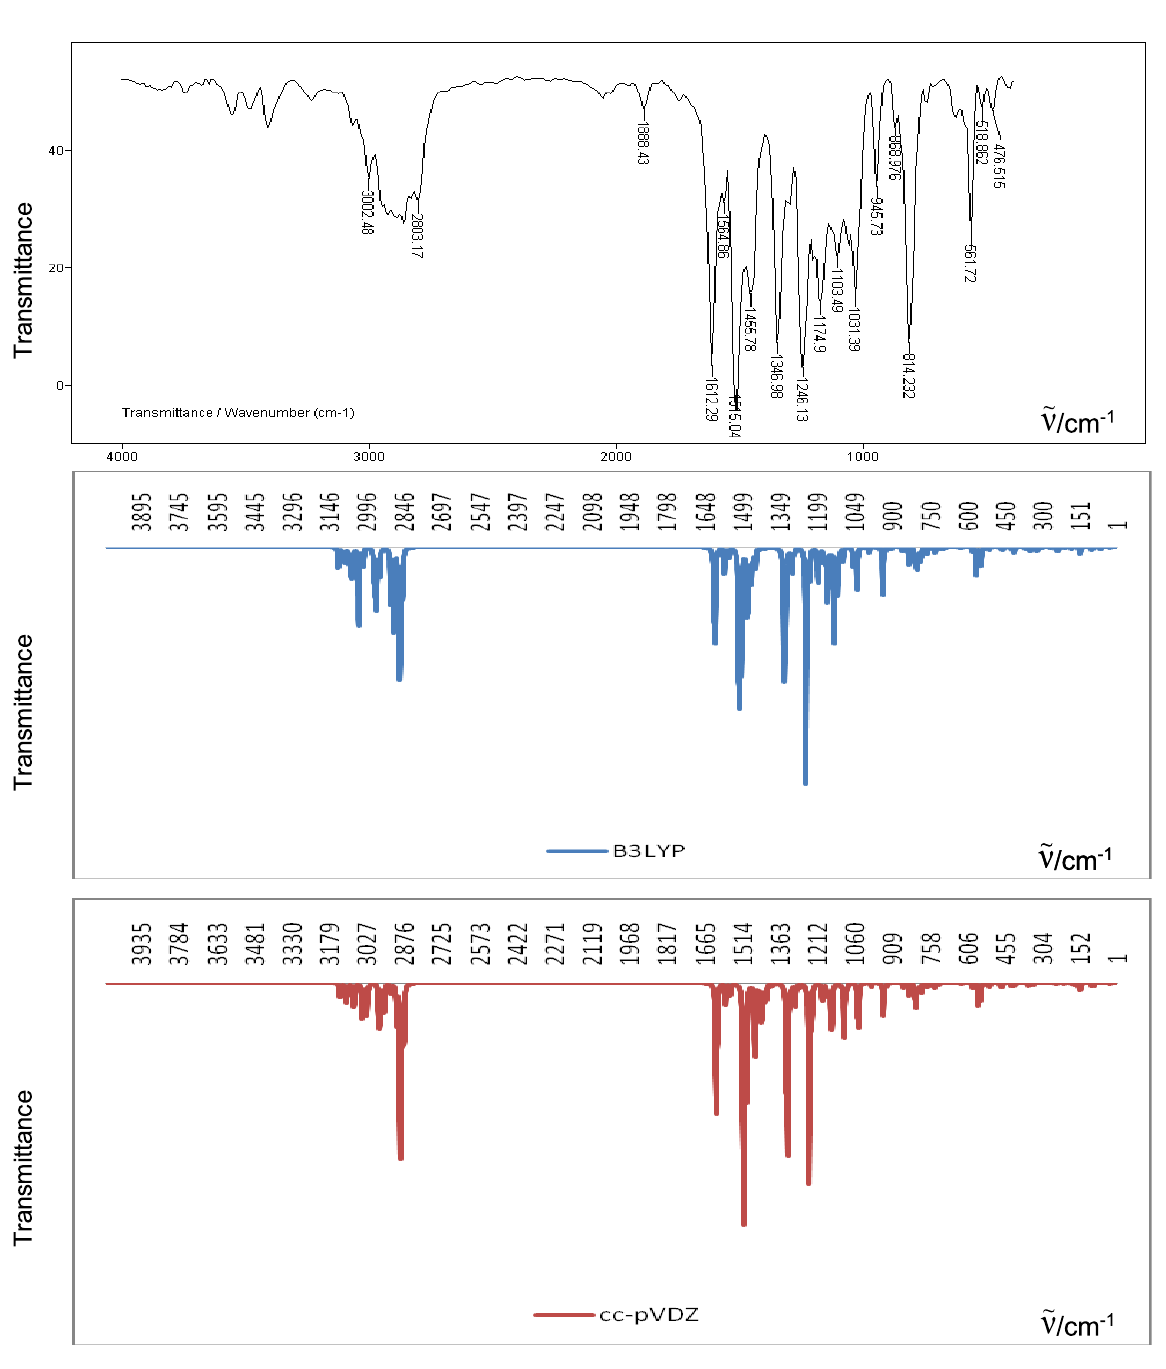
Figure 3: Experimental infrared spectrum of compound 11 and infrared spectrum calculated with B3LYP and cc-pVDZ methods.